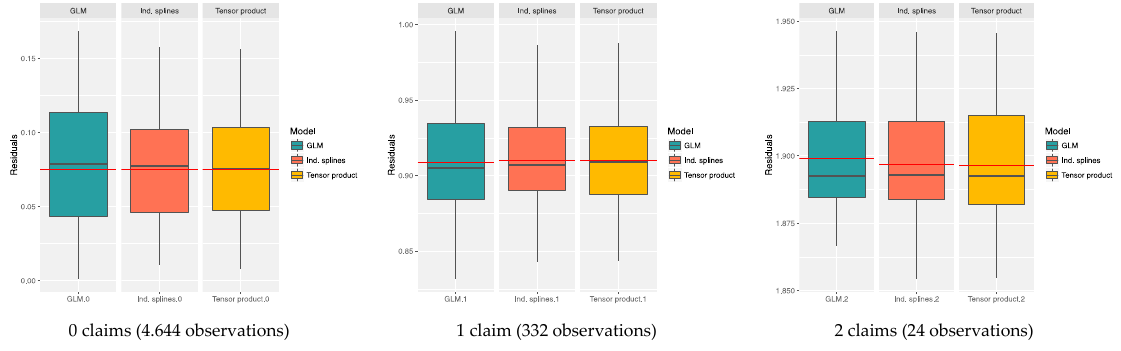
Figure 14. Residuals for insurees with 0, 1 and 2 claims (in each part, left to right GLM, GAM with independent cubic splines and GAM with a tensor product base).